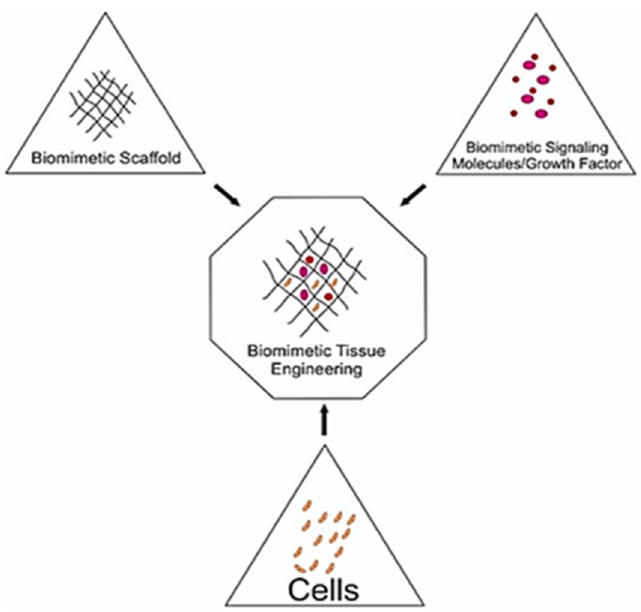
Figure 4. Fundamental components for biomimetic tissue engineering including biomimetic scaffold, signaling molecules and cells.